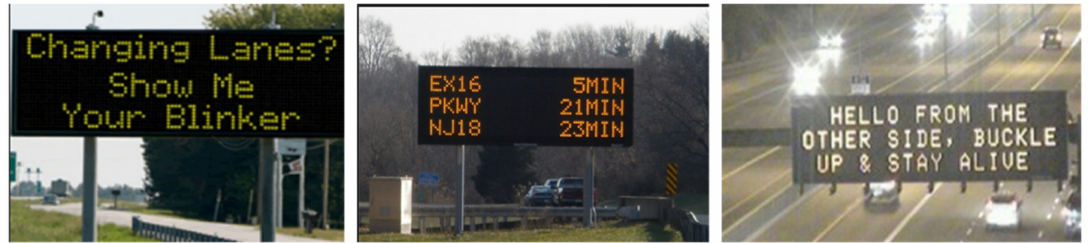
Figure 1. Picture of dynamic message signs (Source: